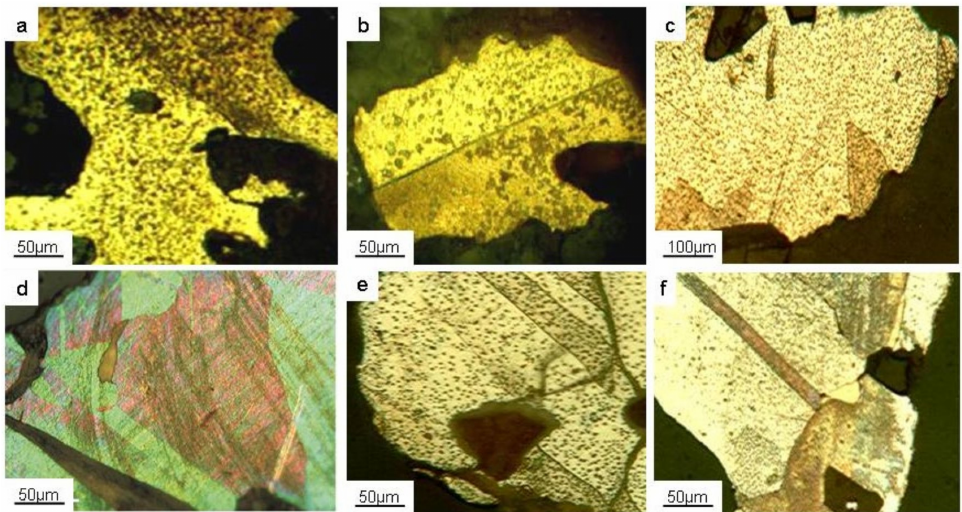
Figure 7. Polygonal-granular structure with simple polysynthetic twins and fine spotted hetero- geneity in native gold from ores of gold–quartz veins GIT deposits: ( a , b ) Butarnoe; ( c , e ) Shkolnoye; ( d ) Maltan, ( f )